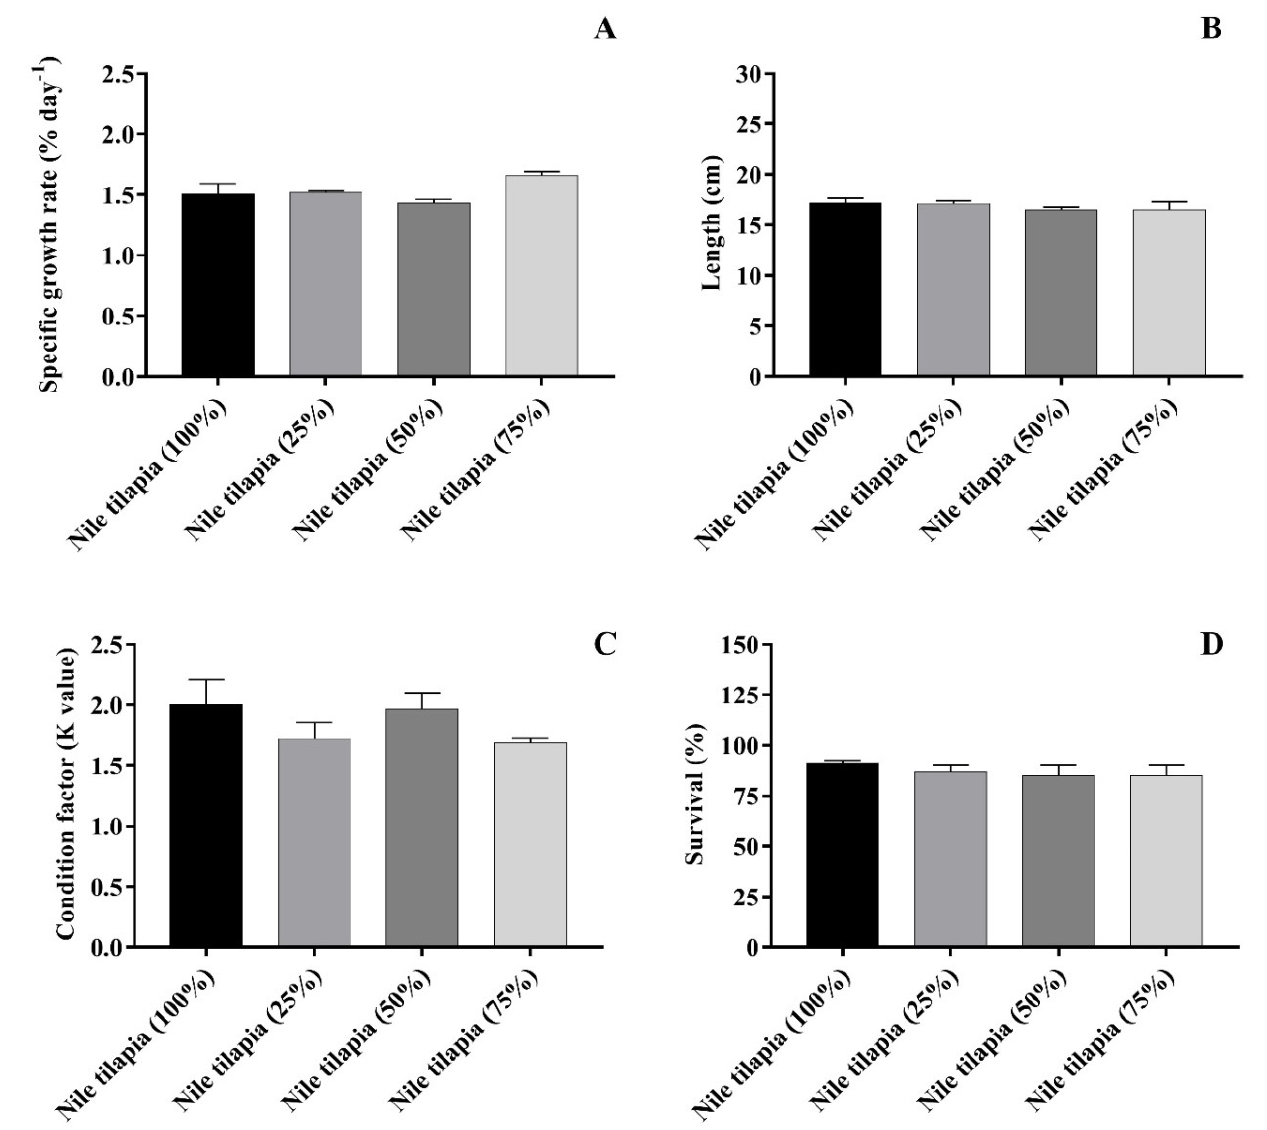
Figure 2. Growth performance ( A – C ) and survival % ( D ) of Nile tilapia, Oreochromis niloticus , maintained in monoculture and different polyculture proportions.